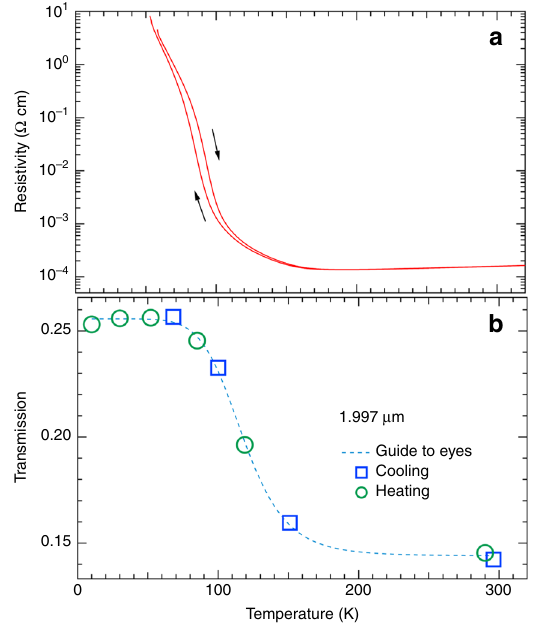
Fig. 2 Temperature dependence of electrical resistivity and optical transmission of a V 1 − x W x O 2 ( x = 0.06) thin fi lm. a Temperature dependence of electrical resistivity ( ρ ). The arrows indicate heating and cooling processes. b Temperature dependence of the optical transmission at 1.977 μ m. The transmission measured in cooling process and that in heating process are represented with blue open squares and green open circles, respectively. The error bar is as large as the size of the square and circle marks in the plot. panel of Fig. 3, the magnetic fi eld (blue curve) increases with time ( t ) and reaches 520 T at 48.4 μ s after the ignition of the gap switches of the capacitor bank power supply at t = 0. Figure 3 shows the t evolution of the transmitted light intensity at 14 K with a red curve. The lower panel of the fi gure shows a magni fi ed view of the region from 50 to 520 T. The optical transmission at